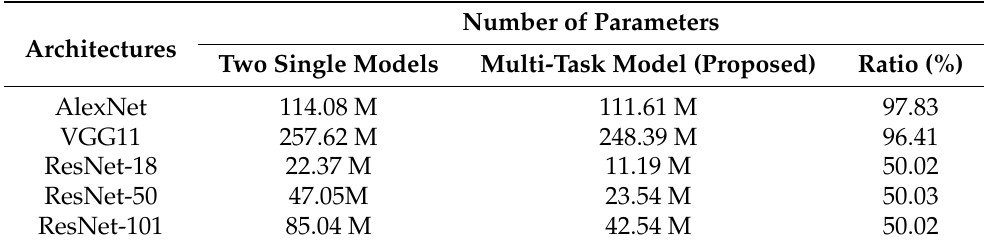
Table 2. Comparison of the number of parameters between the multi-task model and two single models.